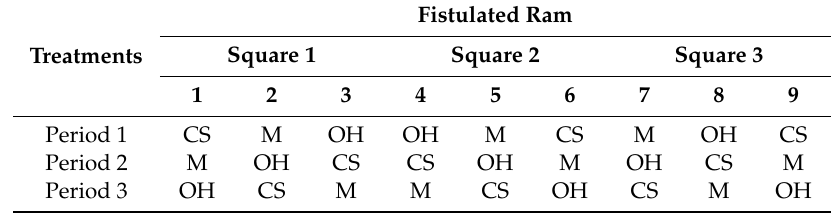
Table 1. The experimental design for evaluating 3 kinds of roughage using 9 fistulated rams.